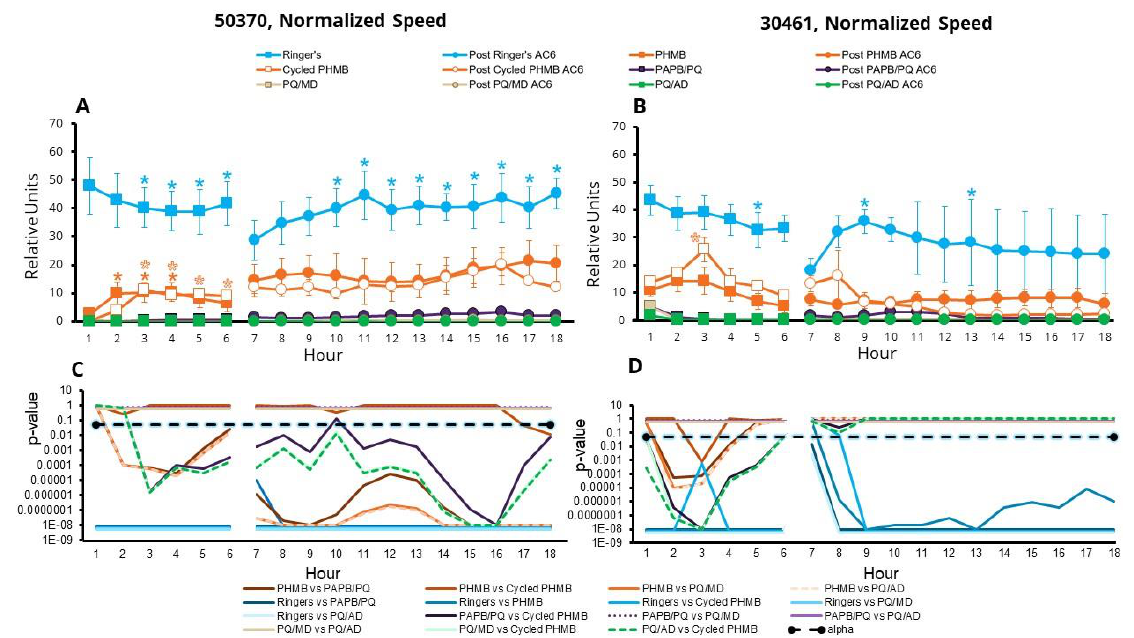
Figure 6. Surviving Acanthamoebae recover speed after disinfection. Amoebae were disinfected or put in one-quarter Ringer’s solution for the first 6 h, followed by AC6 media for the following 12 h (total 18 h). Speed is presented as mean ± SE µm per second, multiplied by the number of moving amoebae per field of view (relative units). ( A ) Acanthamoeba castellanii (ATCC 50370), and ( B ) Acanthamoeba polyphaga (ATCC 30461). * p < 0.05 vs. each condition’s own baseline (either hour 1 or hour 7 for CLC or AC6 conditions, respectively). Statistical comparisons between conditions are represented in ( C ) p -values for ( A ), and ( D ) p -values for ( B ). Alpha was set at 0.05. n = 3/group.